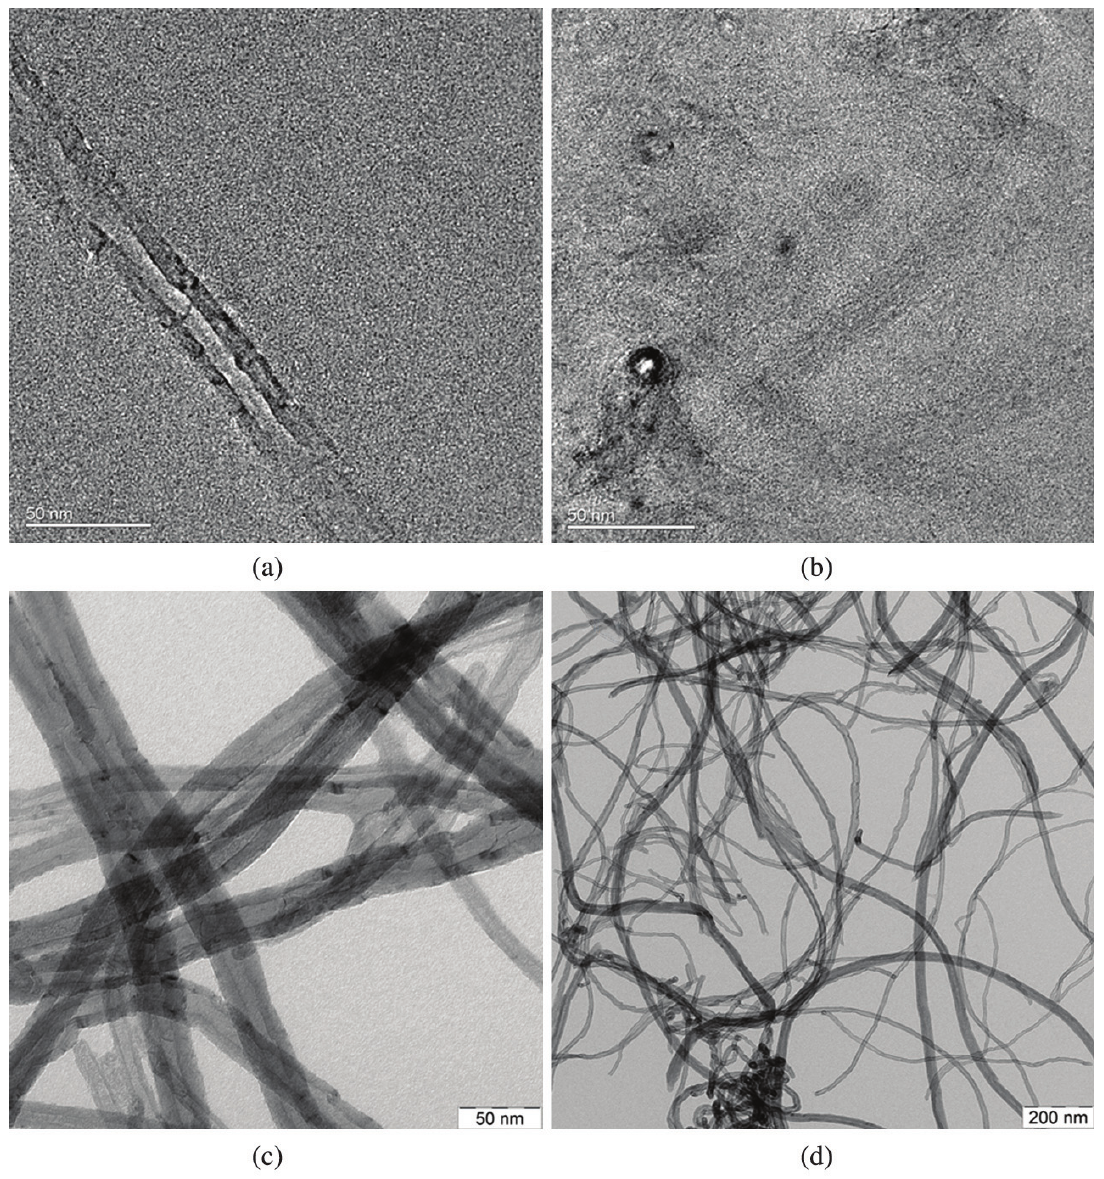
Figure 2. TEM micrographs showing nanotubes: (a) parallel to the cutting direction for 0.62MWCNT/PMMA; (b) random cutting direction for 0.62MWCNT /PMMA; (c) and (d) for pure